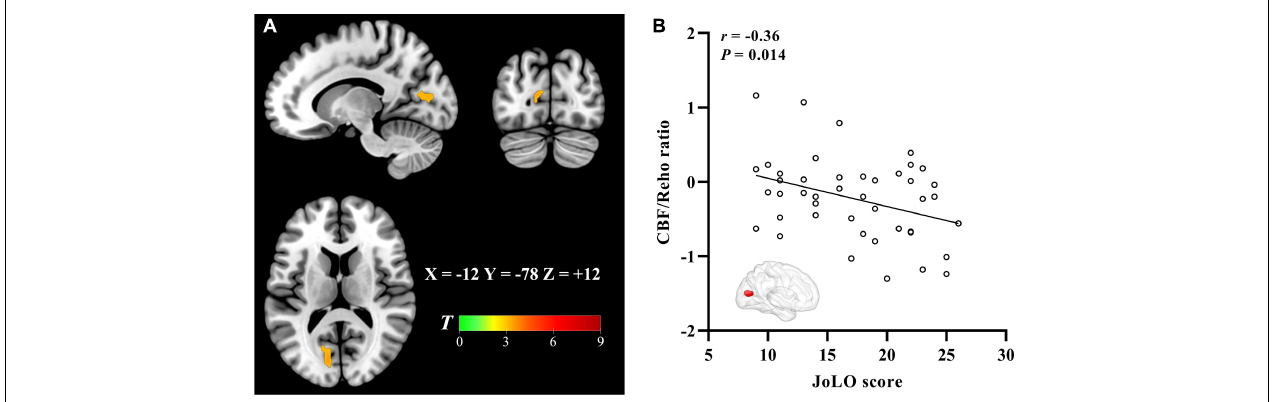
FIGURE 5 | The brain regions with the significant CBF-ReHo ratio difference between PD-MCI and PD-NC groups and correlation to visual–spatial function. The voxel-based analysis demonstrates the survived clusters between PD-MCI and PD-NC groups (A) . These clusters are referred to multiple comparisons correction using the FWE rate (a cluster-defining threshold of P = 0.001 and a corrected cluster significance of P < 0.05). Significantly increased ratio relative to PD-NC in the group is shown with warm color. (B) Correlations between the scores of JoLO ( X -axis) and CBF-ReHo ratio values in the left lingual gyrus ( Y -axis). CBF, cerebral blood flow; ReHo, regional homogeneity; PD, Parkinson’s disease; NC, normal cognition; MCI, mild cognitive impairment; FWE, familywise error; JoLO, Benton’s Judgment of Line Orientation. TABLE 2 | Descriptions of significantly different brain regions in the CBF-ReHo ratio among groups. Brain regions (AAL) Peak MNI coordinates (mm) Peak F